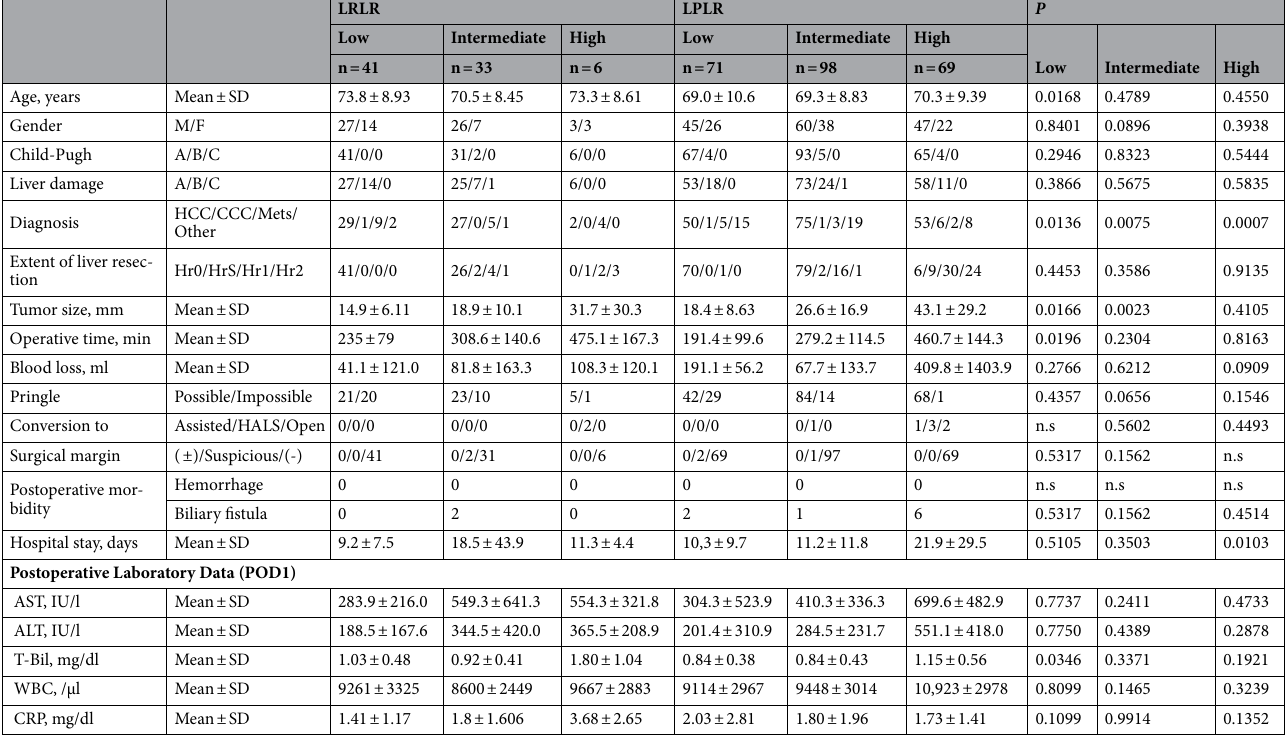
Table 4. Patient characteristics and surgical results of laparoscopic repeat liver resection classified by difficulty score. HCC hepatocellular carcinoma, CCC cholangiocellular carcinoma, Mets metastasis, HALS hand-assisted laparoscopic surgery, n.s. not significant.